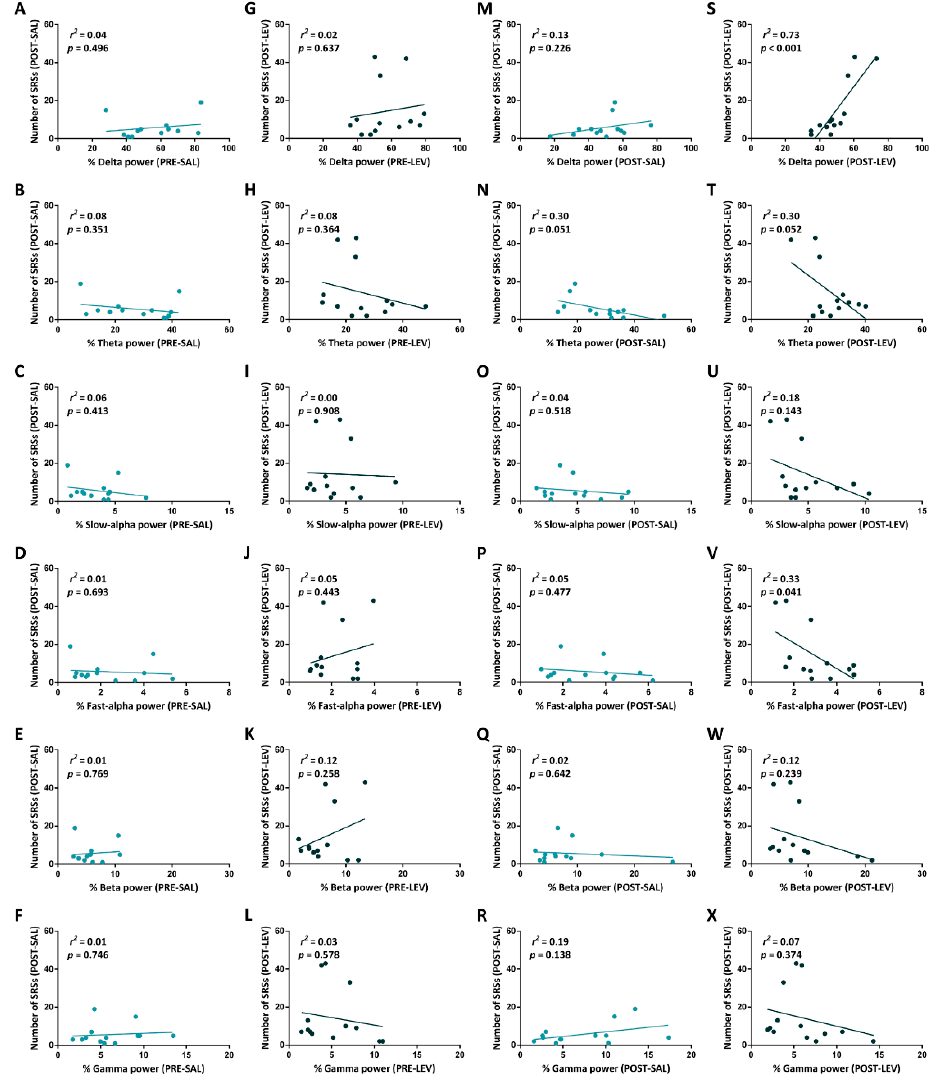
Figure 4. Relationship between power band spectrum and spontaneous recurrent seizures (SRSs) following treatment with levetiracetam (LEV) or saline. Epileptic animals treated with LEV ( n = 13) and epileptic rats treated with saline ( n = 13) were used to evaluate whether a relationship existed between changes in the power band spectrum during the postictal events, and the number of SRSs in the week following the treatment. The relationship ( r 2 ) between the frontal power band spectrum in the pre-treatment interval and the number of SRSs in the week following saline administration were determined as in ( A – F ). Relationship between the frontal power band spectrum in the pre-treatment interval and the number of SRSs in the week following LEV treatment were shown in ( G – L ). Similarly, relationship between the frontal power band spectrum in the post-treatment interval and the number of SRSs in the week following saline administration were illustrated in ( M – R ). Finally, relationship between the frontal power band spectrum in the post-treatment interval and the number of SRSs in the week following LEV administration were illustrated in ( S – X ). Statistical analysis was performed using a linear regression analysis with number of seizures being the dependent and the frontal power band spectrum as the independent variable. PRE-, before osmotic minipump implantation; POST-, after minipump implantation; SAL,